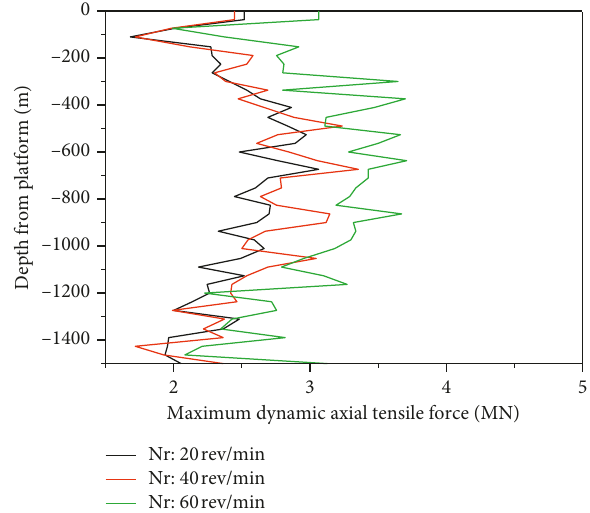
Figure 22: Effect of bit speed on maximum dynamic axial tensile